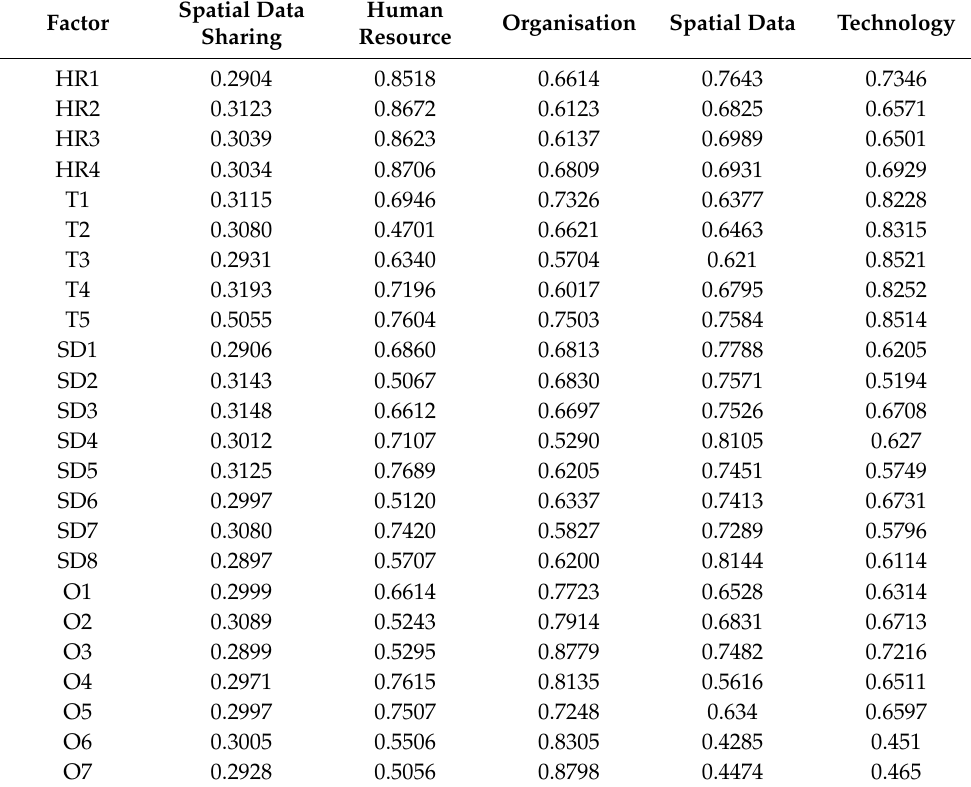
Table 7. Cross-loading value of each factor to its latent variable in this